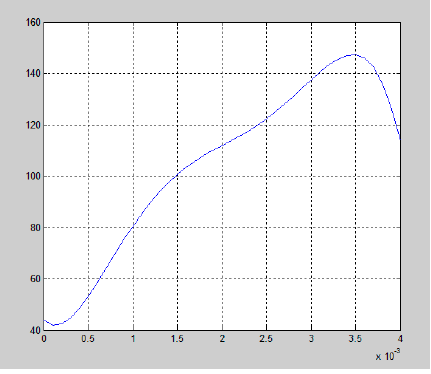
Figure 5. Curve for changes in milling temperature over time.